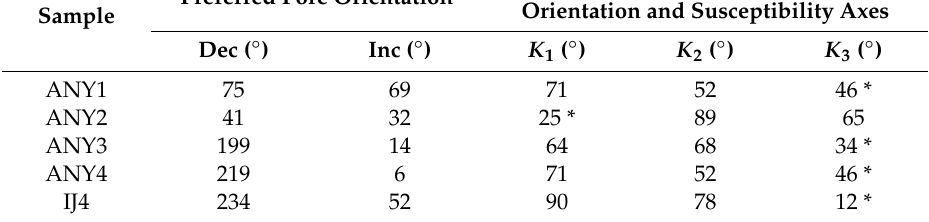
Table 5. Preferred pore orientation calculated using the Directionality plugin from ImageJ and the angle between preferred pore orientation and either K 1 , K 2 , or K 3 . * indicates the closest axis to the preferred